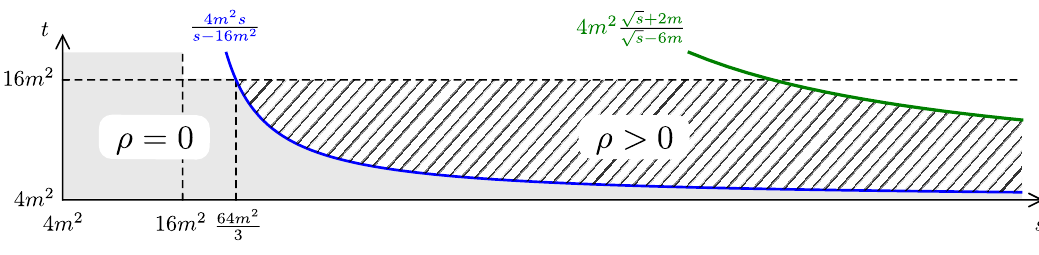
Figure 7 . The regime of positivity of the double spectral density ρ ( s, t ) in the elastic strip 4 m 2 < t < 16 m 2 , (dashed region). This is the region above the first Karplus curve s 1 ( t ) (in blue) and √ s +2 m √ below the curve t = 4 m 2 (in green). There is an identical positive region in the crossed strip s − 6 m of 4 m 2 < s < 16 m 2 , see